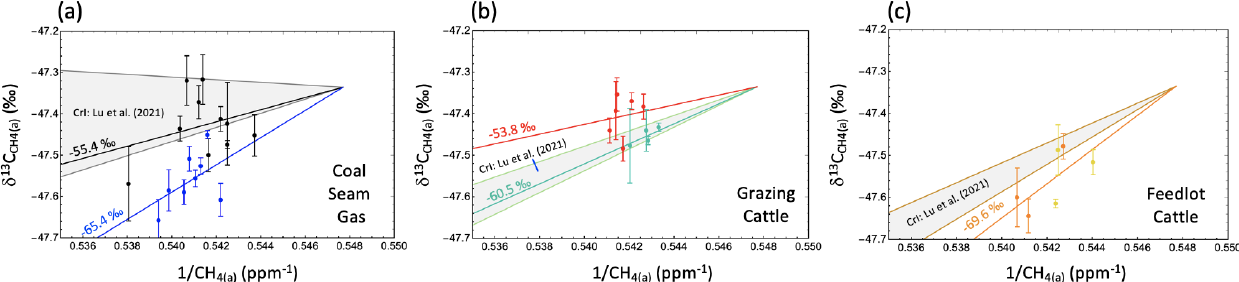
for each CH 4 source category. The expected source category δ 13 C CH values from Lu et Figure 6. Expected versus measured δ 13 C CH 4(a) 4(s) al. (2021), Table A1, are shown as thin continuous Keeling lines (without number values) for the upper and lower Bayesian credible interval for the category (where the credible interval is analogous to the 95% confidence interval). The thick lines represent Keeling lines based on the IFAA samples (including derived source signatures). The IFAA sample point and measurement uncertainty are also shown for each category data set. The categories are (a) CSG > 50% BTF inventory, 100–200ma.g.l. (blue), and CSG > 50% BTF inventory, 250–350ma.g.l. (black); (b) grazing cattle > 50% BTF inventory, 100–200ma.g.l. (red), and grazing cattle > 50% BTF inventory, 250–350ma.g.l. (green); (c) feedlots > 50% BTF inventory, 100–350ma.g.l. (yellow points (100–200ma.g.l.) and orange points (250–350ma.g.l.)). All error